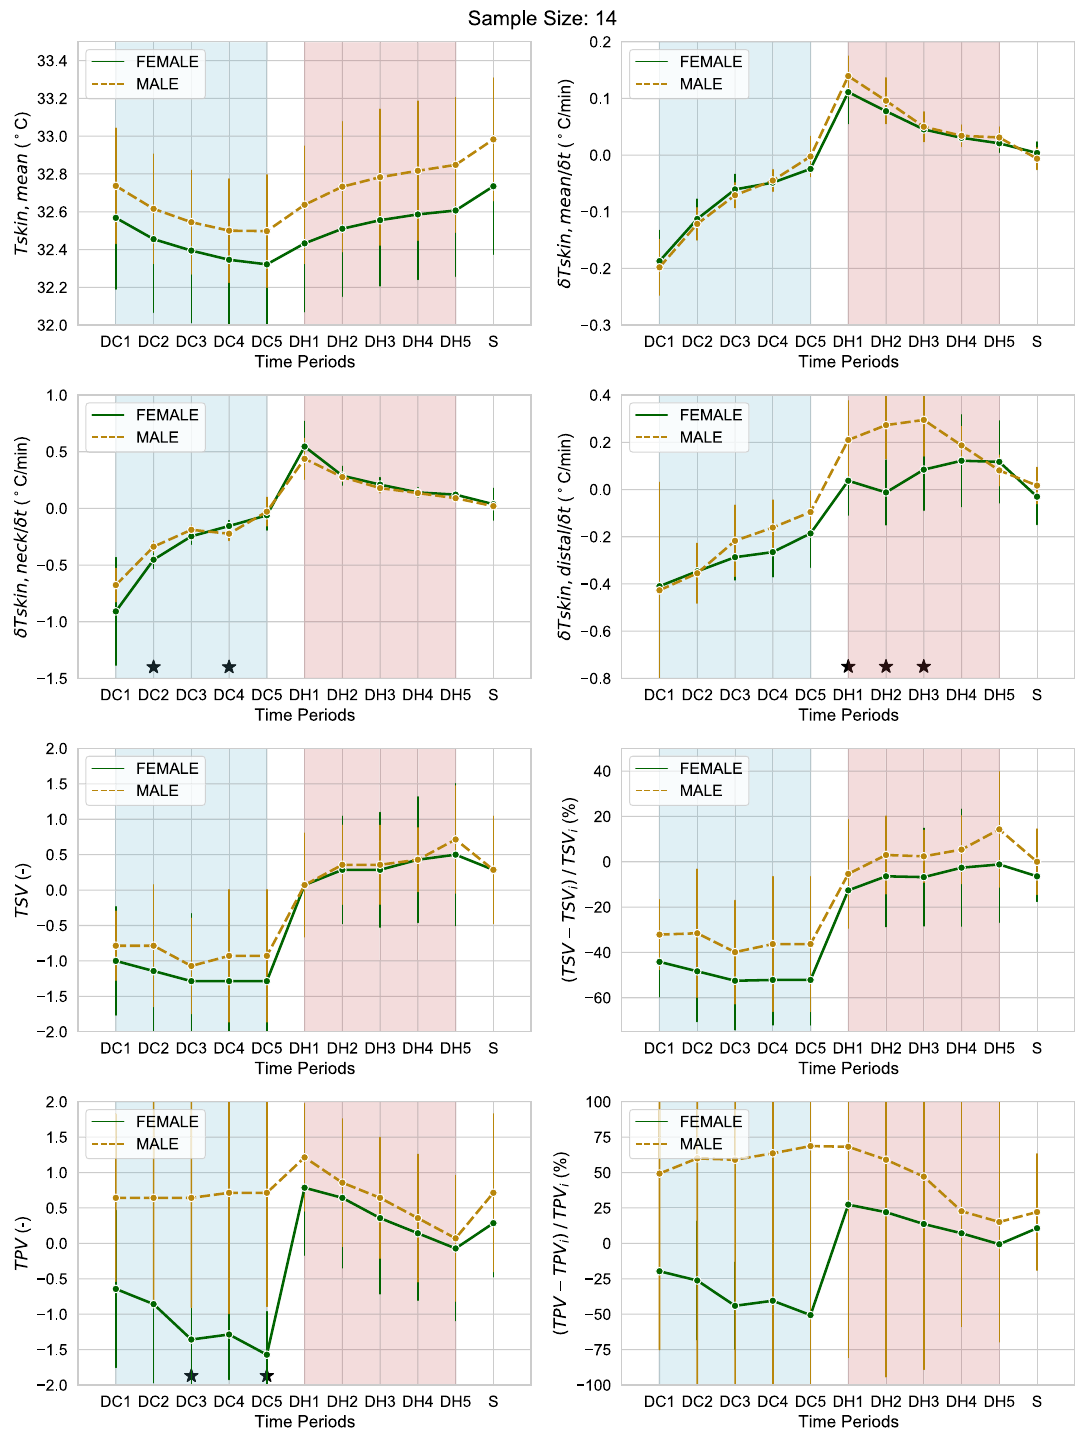
Figure 8. Skin temperature at various locations, subjective thermal sensation and thermal pleasure vote and their rate of change for females and males averaged over the course of the last two partial-body cooling and warming transients. Thus, only data collected after 120 min from the beginning of the test are reported. Asterisks indicate statistically significant differences. Error bars represent one standard